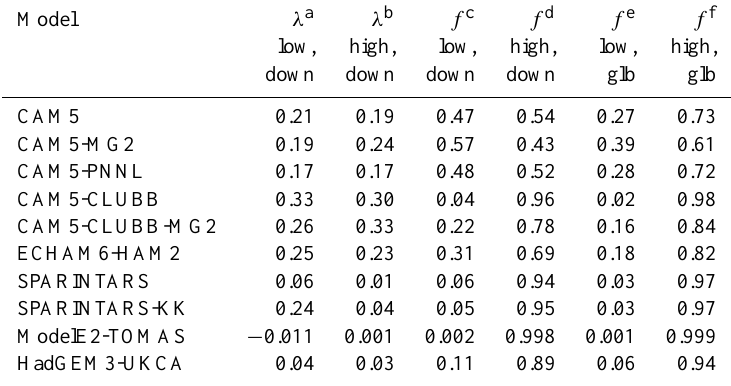
Table 4. The fractional occurrences of low and high surface precipitation in PD cases over downdraft regimes ( ω 500 > 0hPaday − 1 ) and global oceans and λ under these low and high surface precipitation situations only over downdraft regimes. Low precipitation situations refer to monthly surface precipitation rate (PRECL) less than 0.1mmday − 1 while high precipitation situations refer to PRECL larger than 0.1mmday − 1